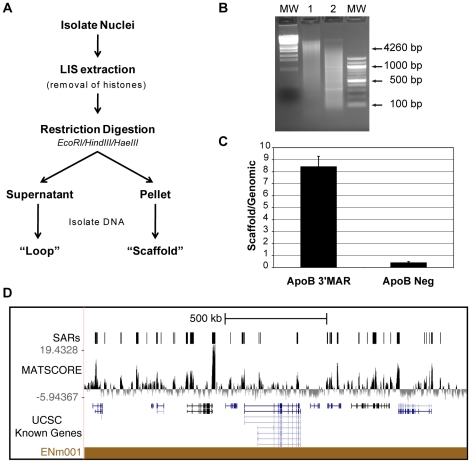
Isolation and identification of HeLa scaffold attachment regions.A.) Overview of nuclear scaffold isolation procedure. B.) Recovered DNA from Loop (Lane 1) and Scaffold (Lane 2) fractions after electrophoresis on a 1.5% agarose gel. MW represents molecular weight markers: Lambda DNA digested with StyI and 100 bp DNA ladder (NEB). C.) Quantitative PCR results for the ApoB 3′MAR and ApoB negative region. Mean ± S.D of three measurements. D.) Results of microarray analysis of scaffold DNA for ENCODE region ENm001. The MAT score profile and regions identified as SARs are shown in relationship to UCSC annotated genes.